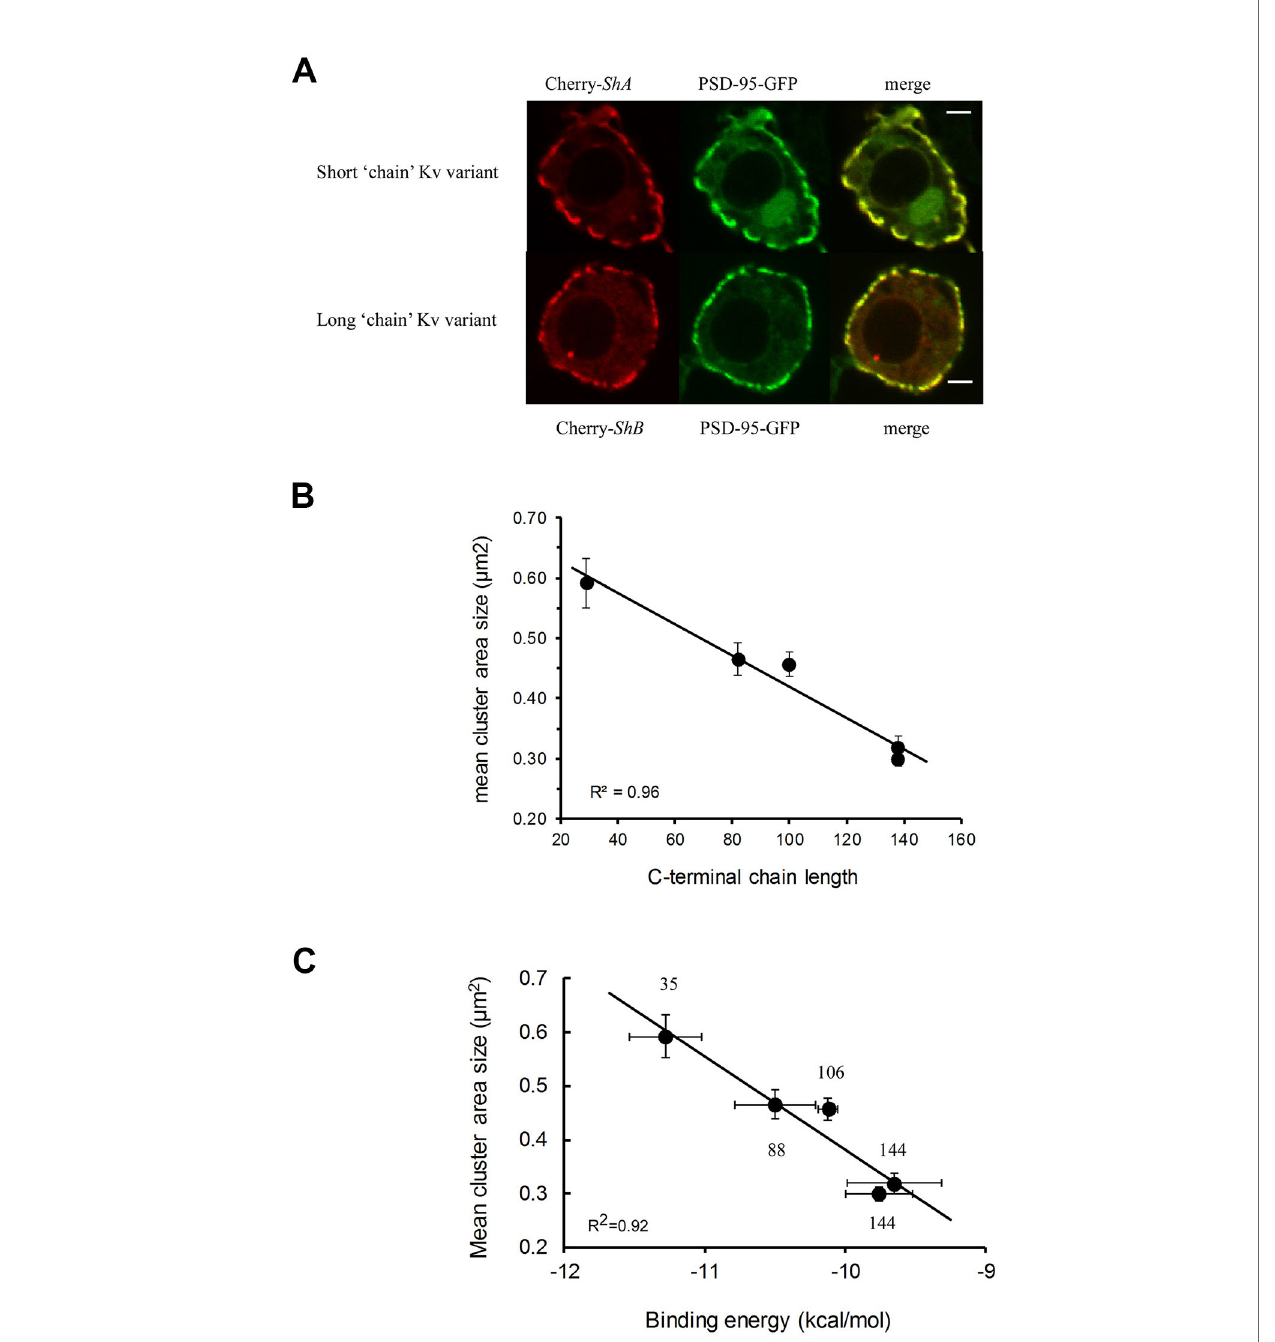
FIGURE 3 | Molecular and cellular correlates in PSD-95 – mediated Kv channel clustering. (A) Typical confocal microscopy analysis of Drosophila Schneider S2 cells co-expressing PSD-95 – GFP and either the short or long native (alternatively-spliced) Kv channel “ chain ” length variants. For each cell, three images are shown, with the red channel-associated and green PSD-95-associated fl uorescence signals presented in the left and middle columns, respectively. The merged image is shown in the right column. Scale bars correspond to 2 m ;m. Numbers next to each channel notation indicate C-terminal amino acid “ chain ” length (adopted with permission from Zandany et al., 2015a). (B) Dependence of the mean mega-cluster area size of different Kv channel “ chain ” length variants on the C-terminal “ chain ” length. The solid curve corresponds to linear regression with an R 2 value of 0.96. (C) Correlation plot relating the mean cluster area size of the different Kv channel “ chain ” length variants, as supported by PSD-95, and the binding af fi nity of the different variants to PSD-95. The solid curve represents linear regression between the compared quantities ( R 2 = 0.92). It is possible that such a linear correlation breaks down for too short “ chains ” due to steric considerations stemming from the inability of multiple Kv channel molecules to bind PSD-95 when the “ chain ” is too short. Numbers next to each channel notation indicate C-terminal “ chain ” length in terms of amino acid numbers. PSD, post-synaptic